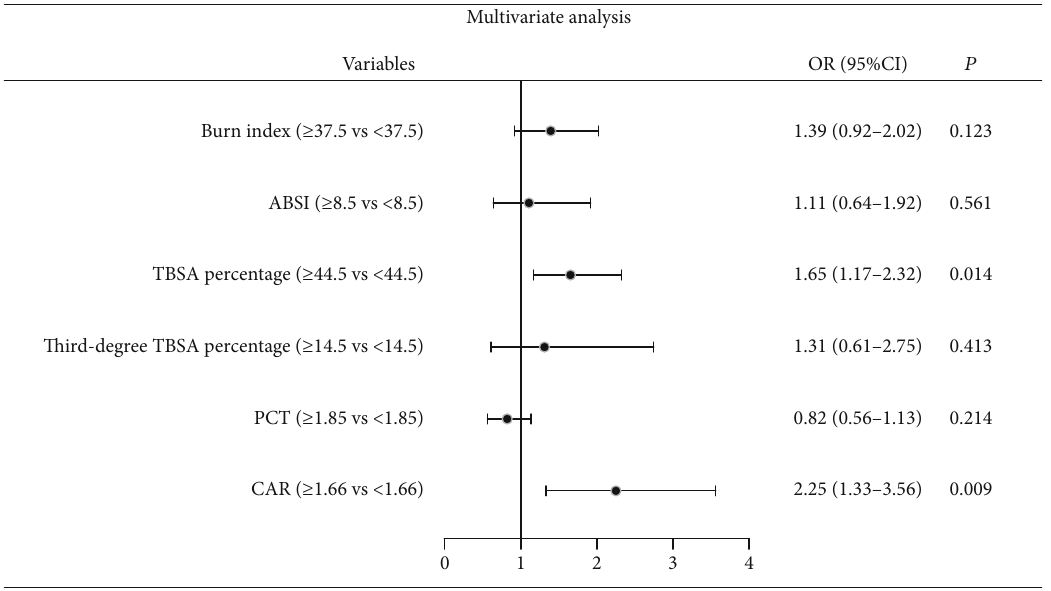
Figure 4: Forest plot of risk factors for sepsis by the multivariate logistic regression analysis. ABSI: abbreviated burn severity index; TBSA: total burn surface area; PCT: procalcitonin; CAR: C-reactive protein-to-albumin ratio; OR: odds ratio; CI: con fi dence